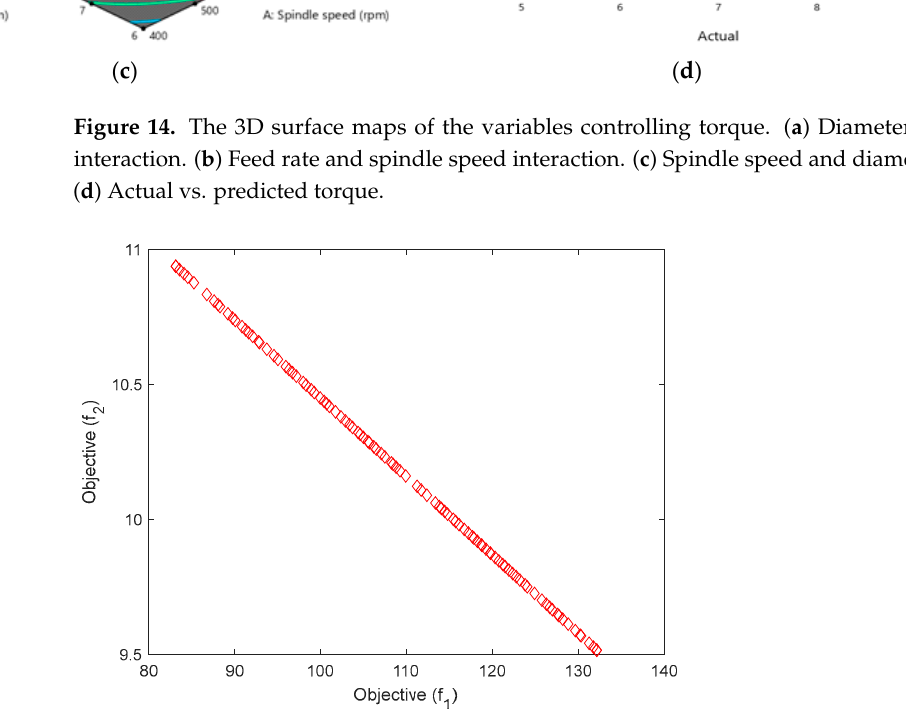
Figure 15. Pareto chart for multiobjective optimisation. Objective (f1) = thrust force, objective (f2) =